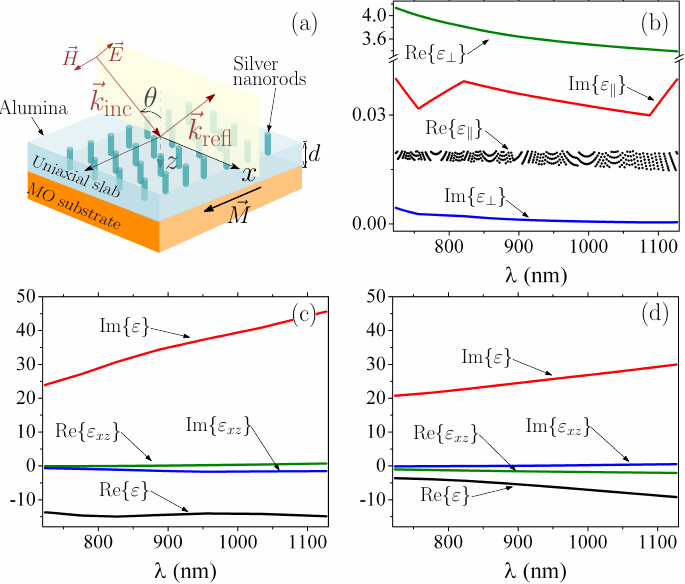
Figure 1. ( a ) Schematic representation of the uniaxial magnetophotonic metasurface. The p -polarized incident light is also illustrated, with M placed transverse to the incident plane. ( b ) ε -near-zero permittivity components of the uniaxial slab, of thickness d , as function of the free-space incident wavelength ( λ ). ( c ) and ( d ) show the permittivity components for the MO substrate when made of Co and Fe,